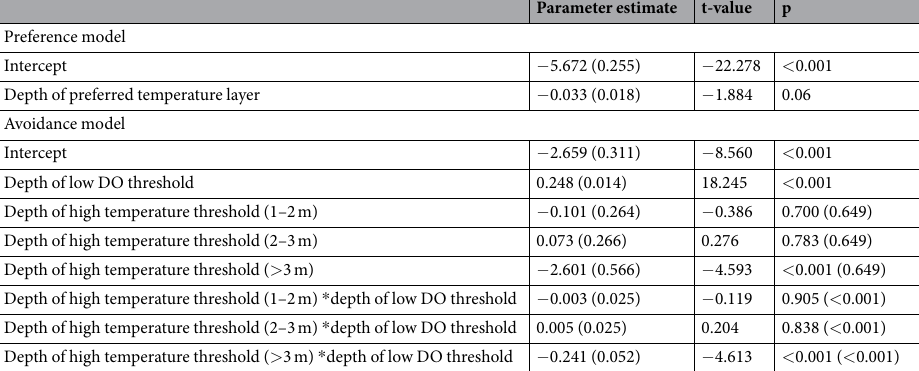
Table 3. Model parameters for the preference and avoidance models. Standard error of parameter estimates given in brackets. Overall p-value of categorical variable given in brackets behind level specific p-values. For both models the inclusion of a temporal autocorrelation structure increased the AIC by more than 2, hence the final model was fitted without the correlation